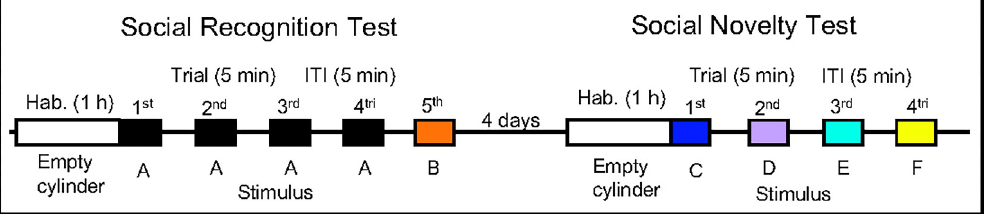
Fig 1. The timeline of the social recognition test (five trials) and the social novelty test (four trials). Both tests were performed after a 1-h habituation period, and all trials were 5 min long [ITI: inter-trial